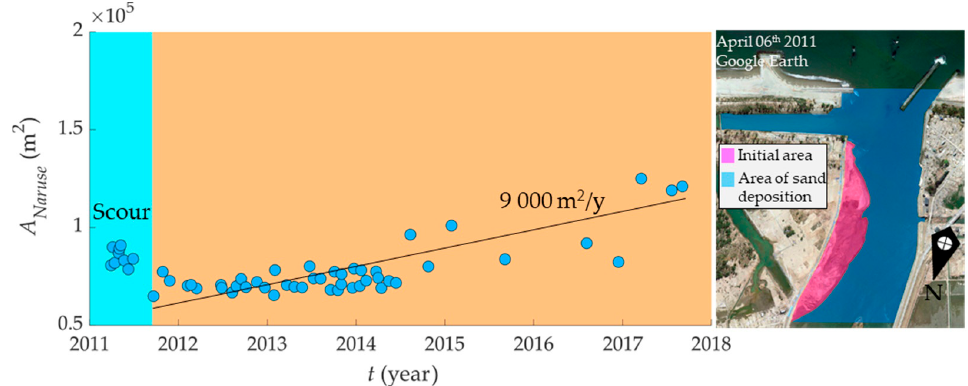
Figure 14. Measured area of sand deposition in the Naruse River mouth.